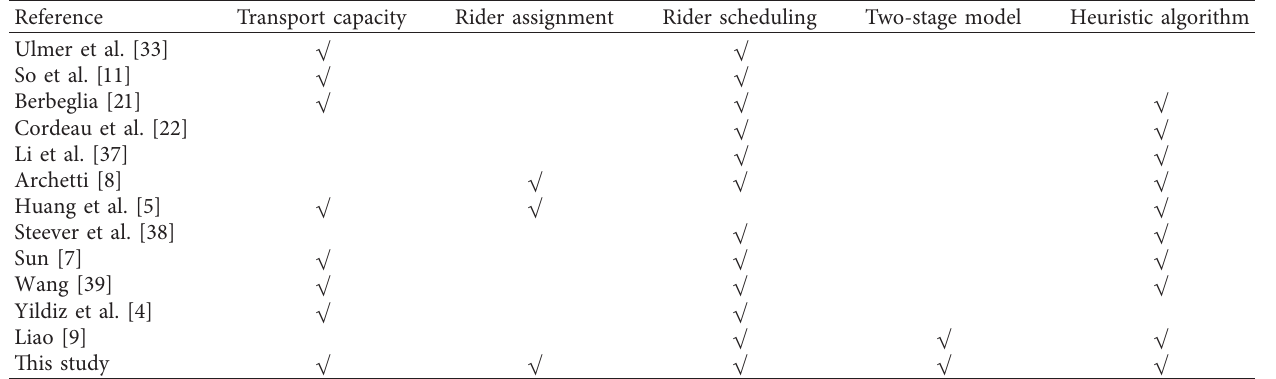
Table 1: Comparison between the existing literature and this